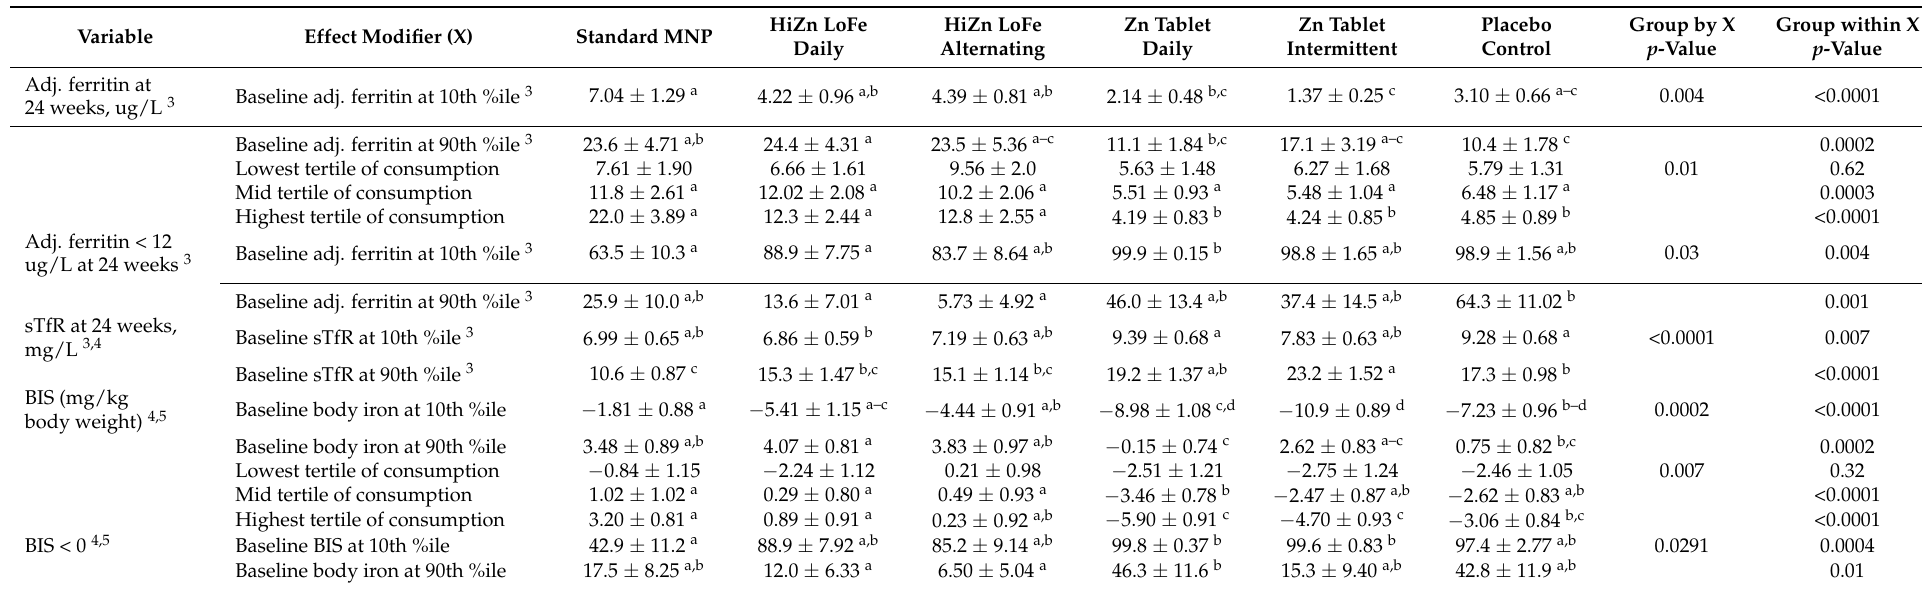
Table 3. Effect modification analysis for iron biomarker concentrations at 24 weeks 1,2